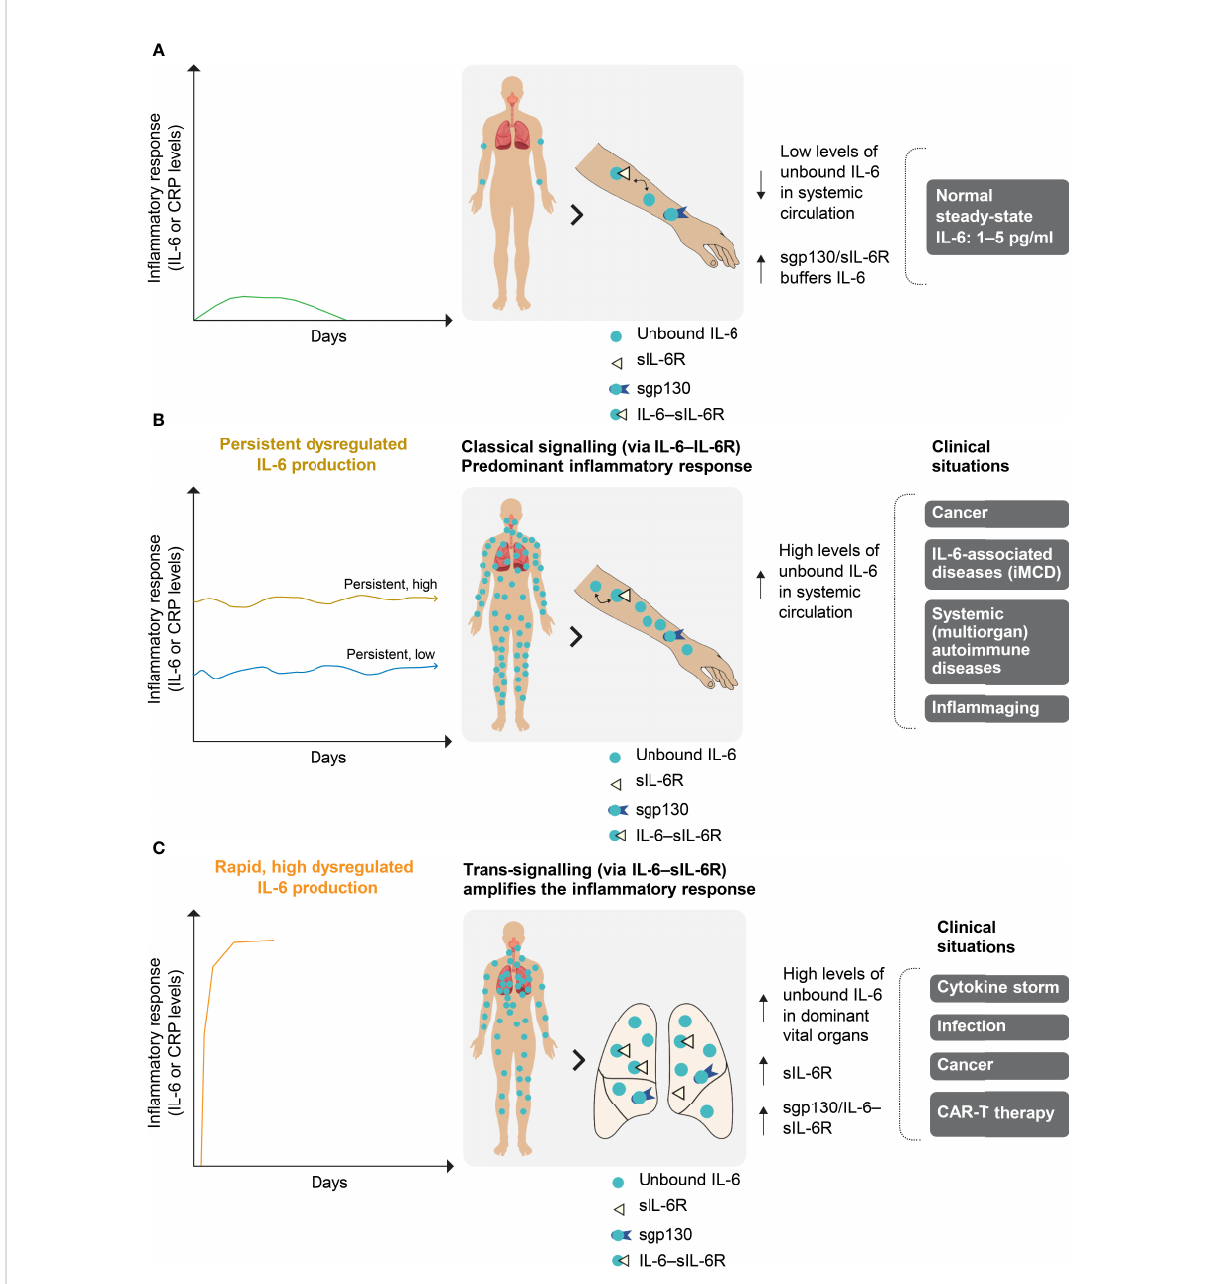
FIGURE 1 Normal (A) and dysregulated (B, C) IL-6 production. (A) In a normal transient IL-6 response, IL-6 is buffered by the sgp130 – sIL-6R complex to ensure immune homeostasis. IL-6 is produced locally at the site of any injury and circulates systemically. The severity of IL-6 dysregulation is linked to the localisation of its production (i.e. in a vital or non-vital organ), as well as its dynamics, duration of increase and level. (B) Persistent dysregulated IL-6 production is seen in cancer, iMCD and systemic autoimmune diseases. The persistent high or low in fl ammatory response associated with these diseases occurs predominantly in the systemic compartment via classical IL-6 signalling. (C) Rapid and highly dysregulated levels of IL-6 induce pro-in fl ammatory trans-signalling that appears to be dominant in local vital organs (e.g. the lungs). This ampli fi es the in fl ammatory response and is a potent activator of endothelial activation, as observed during the cytokine storm that can occur in COVID-19, infections and cancers. iMCD, idiopathic multicentric Castleman disease; CAR-T, chimaeric antigen receptor T cells; CRP, C-reactive protein; gp130, glycoprotein 130; IL-6, interleukin-6; IL-6R, interleukin-6 receptor; s,